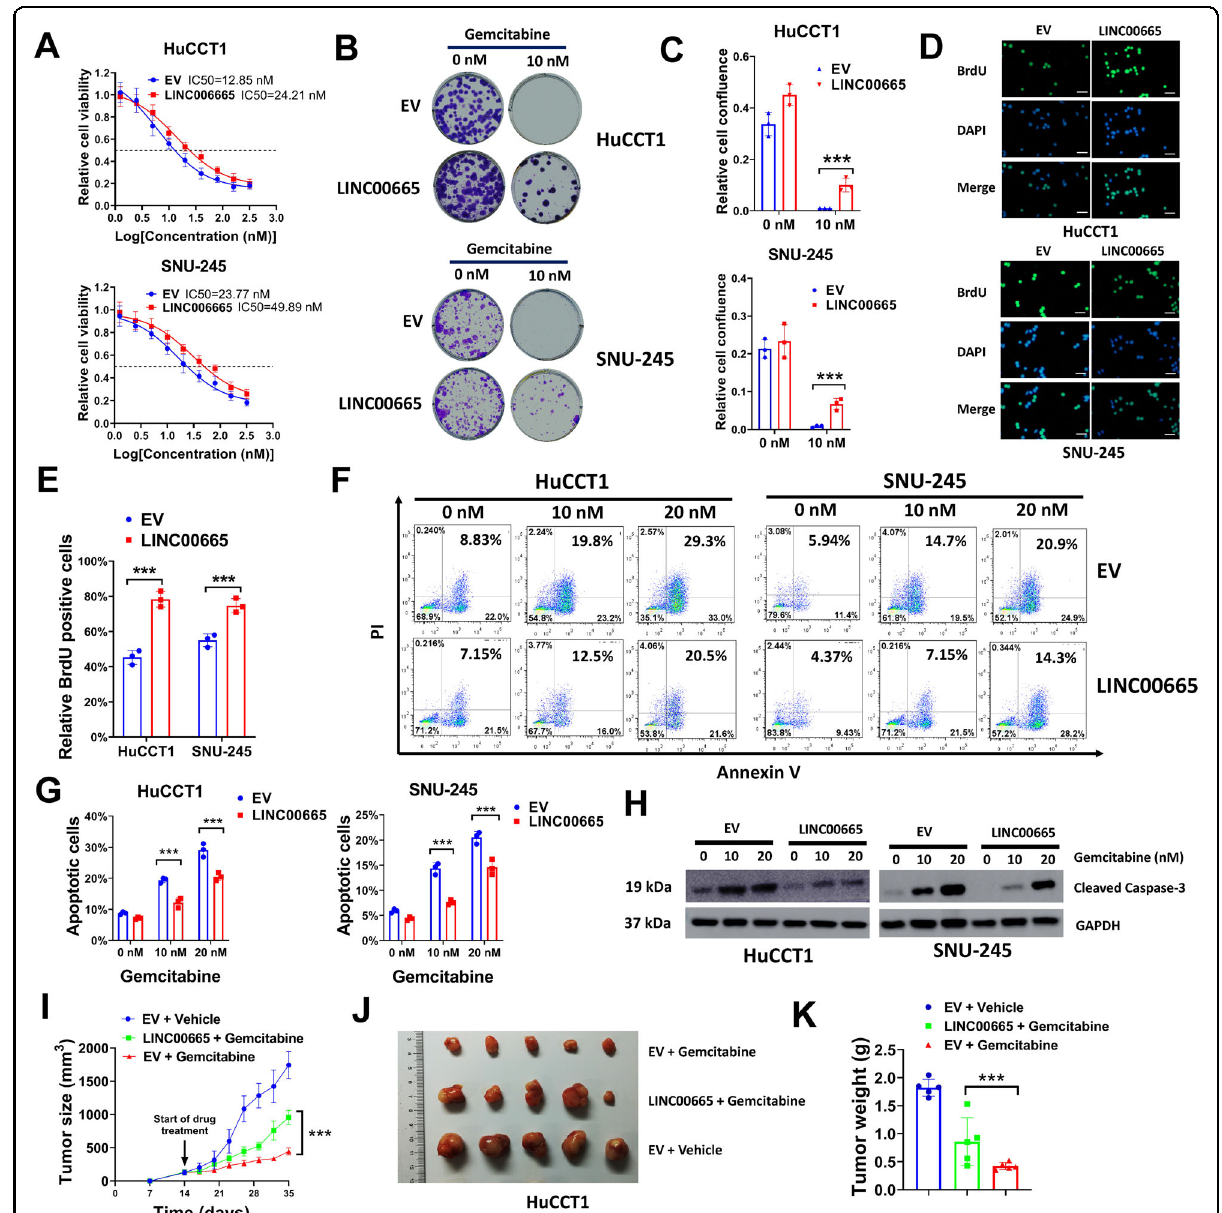
Fig. 3 Enforced LINC00665 expression increases gemcitabine tolerance in sensitive CCA cells in vitro and in vivo. A HuCCT1 and SNU-245 cells transduced with LINC00665 expression lentivirus or EV were seeded in 96-well plates (5000 cells/well) and exposed to 0, 1.25, 2.50, 5.0, 6.25, 10, 20, 40, 80, 160, and 320 nM gemcitabine for 6 d, then assayed for cell viability. B , C HuCCT1 and SNU-245 cells (3000/well) transduced with LINC00665 expression lentivirus or EV were seeded in 6-well plates for colony formation assay, meanwhile treated with 0 or 10 nM gemcitabine. Represent plates ( B ) and relative cell con fl uence ( C ) were shown. D , E HuCCT1 and SNU-245 cells transduced with LINC00665 expression lentivirus or EV were treated with gemcitabine (10 nM) for 24 h, then cells were used for BrdU assay. Represent images ( D ) and relative BrdU positive cells were shown ( E ). F – H HuCCT1 and SNU-245 cells transduced with LINC00665 expression lentivirus or EV were treated with gemcitabine (0 nM, 10 nM, or 20 nM) for 3 days, then cells were stained with Annexin V-FITC and PI for fl ow cytometry ( F , G ), or collected cell lysates for western blot ( H ). I – K HuCCT1 cells (2 × 10 6 ) transduced with LINC00665 expression lentivirus or EV were subcutaneous injected into nude mice, then treated with gemcitabine (100 mg/ kg) or equal volume of PBS (Vehicle control) for three weeks. Tumor growth curves ( I ), represent images ( J ), and tumor weight ( K ) were shown. Scale bars = 100 μ m for BrdU assay. *** P ≤